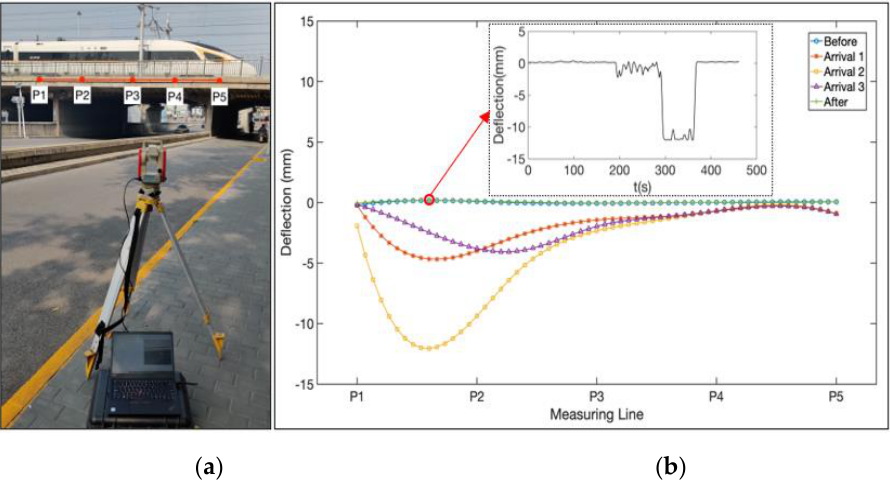
Figure 11. Field experiment: ( a ) setup of the field experiment, ( b ) full-field deflection curves of the bridge that includes five representative moments: before arrival, three selected moments after arrival, and after departure.